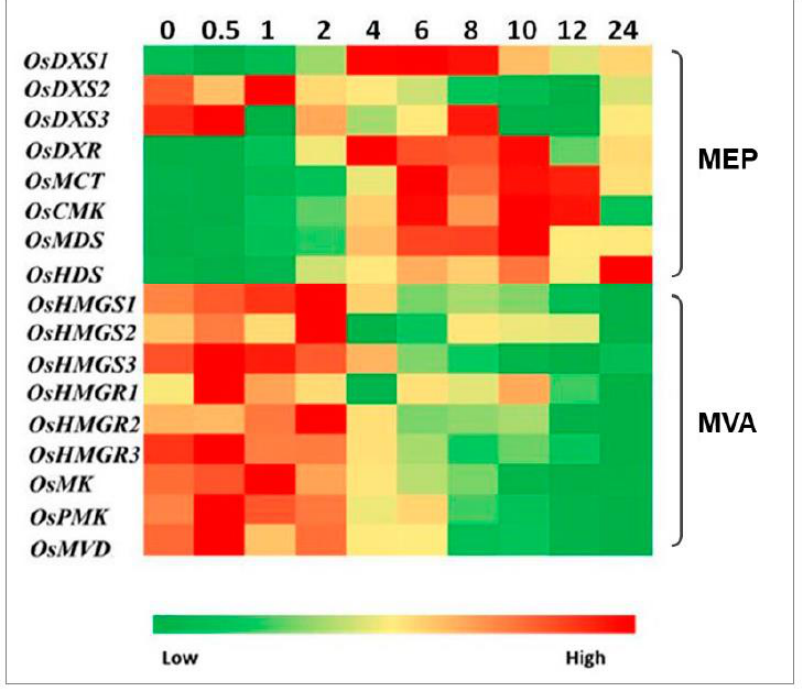
Figure 3. Relative expression levels of the MEP pathway and the MVA pathway genes in etiolated rice leaves during de-etiolation at various times after the onset of irradiation with white light. The expression level of OsDXR (DXP reductoisomerase gene) rose rapidly after 2 h irradiation and reached a peak after 4 h of illumination, which was 7.6-fold higher compared with the dark control. From 4 to 10 h of illumination, the expression level of OsDXR stayed at a high level and then decreased sharply after 12 h irradiation. The high- est expression level of OsMCT (2-C-methyl-D-erythritol 4-phosphate cytidylyltransferase gene) was detected after 6 h of irradiation, which was 12-fold higher than that in